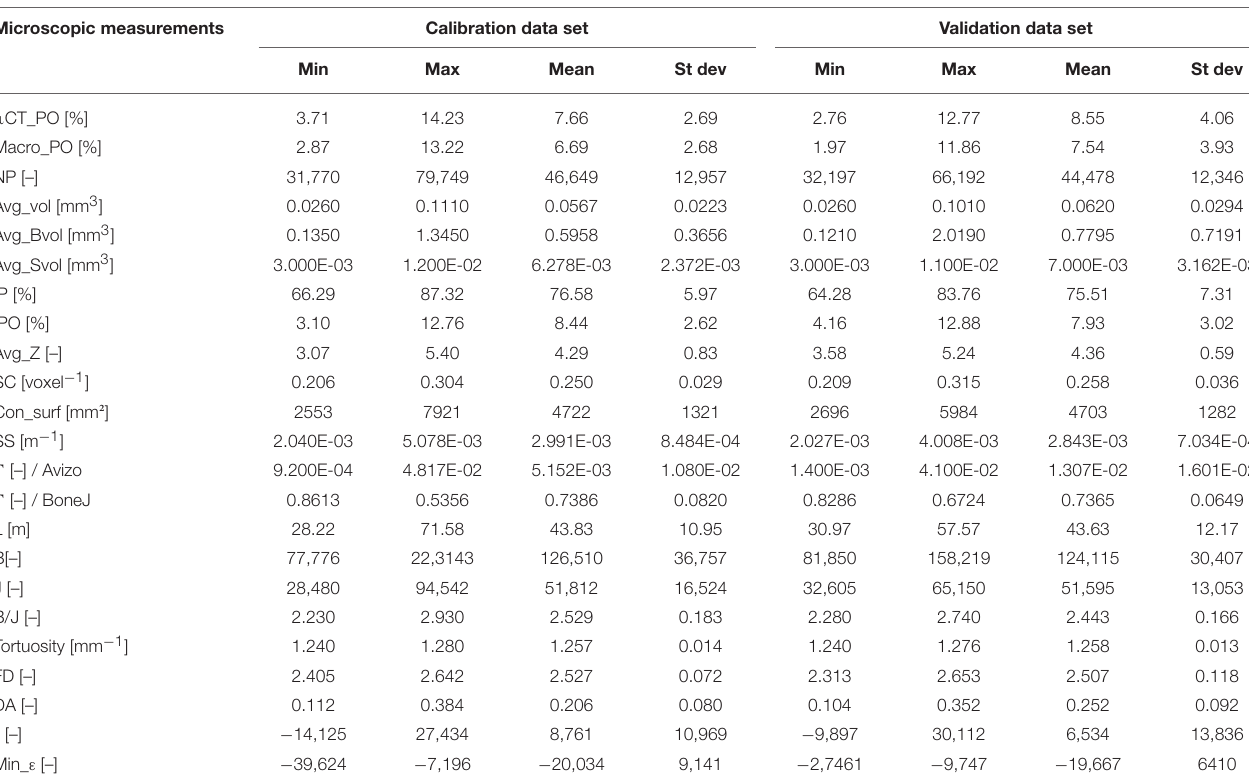
TABLE 3 | Microscopic measurements on µ CT X-ray images for the calibration and validation data set [minimum values (Min), maximum values (Max), mean values (Mean), and standard deviation (St dev)]. Microscopic